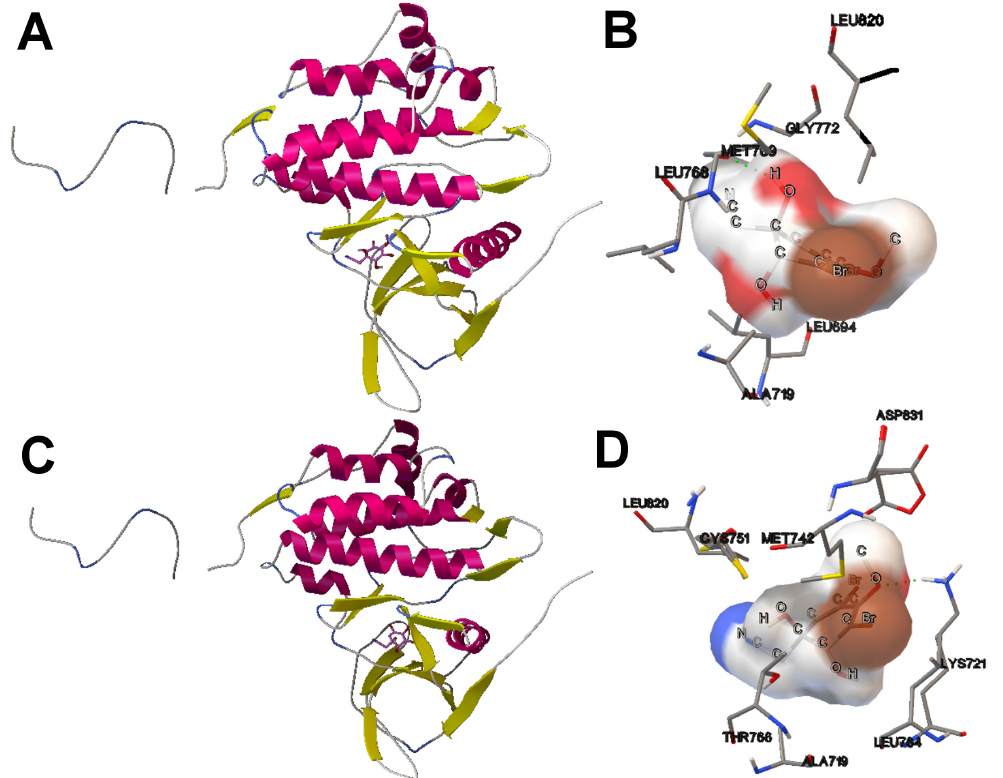
Figure 9. ( A , C ) The tridimensional structure of the EGFR kinase domain with the alpha-helix structure in pink, the beta-strands in yellow and aeroplysinin-1 bound to the cleft between the NH2 and COOH terminal lobes. These aeroplysinin-1 conformations correspond to the results obtained by the SMPSO algorithm (Runs 7 and 23); ( B , D ) The molecular interactions between the aeroplysinin-1 compound and the EGFR receptor. The H-bonds are represented in green spheres. The amino acids of the interaction site and the ligand atoms have been